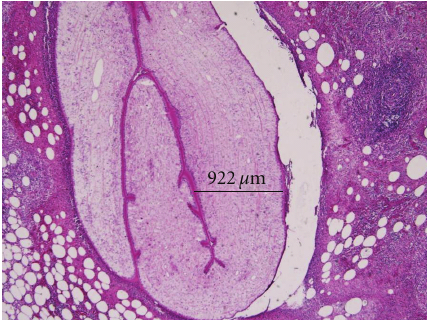
Figure 3: Microscopic view of cross-sections of the nematode (hematoxylin and eosin stain, original magnification